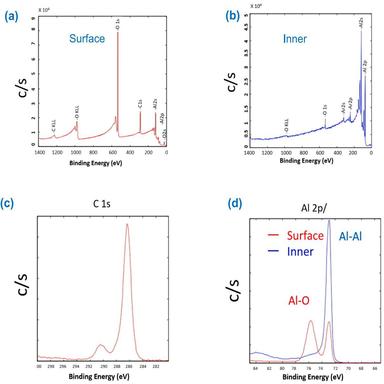
XPS analysis of the AlH3 thin film at the (a) surface; (b) inner 15 nm in-depth; (c) C1s signature; and (d) Al 2p signature. The analysis of the AlH3 thin film at the surface, and inner 15 nm in-depth, shows that while the oxide layer is present at the surface, it is absent within the inner 15 nm depth.